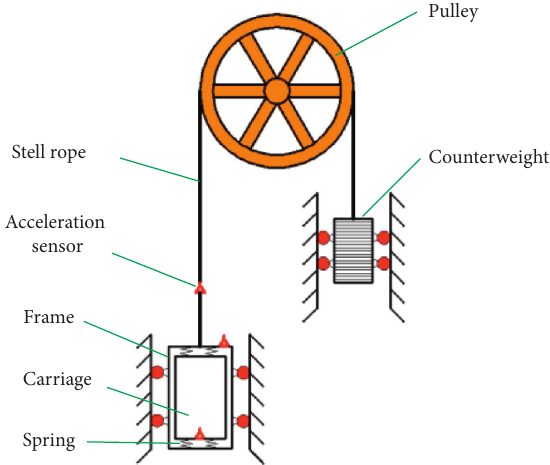
Figure 1: Configuration of the elevator lifting